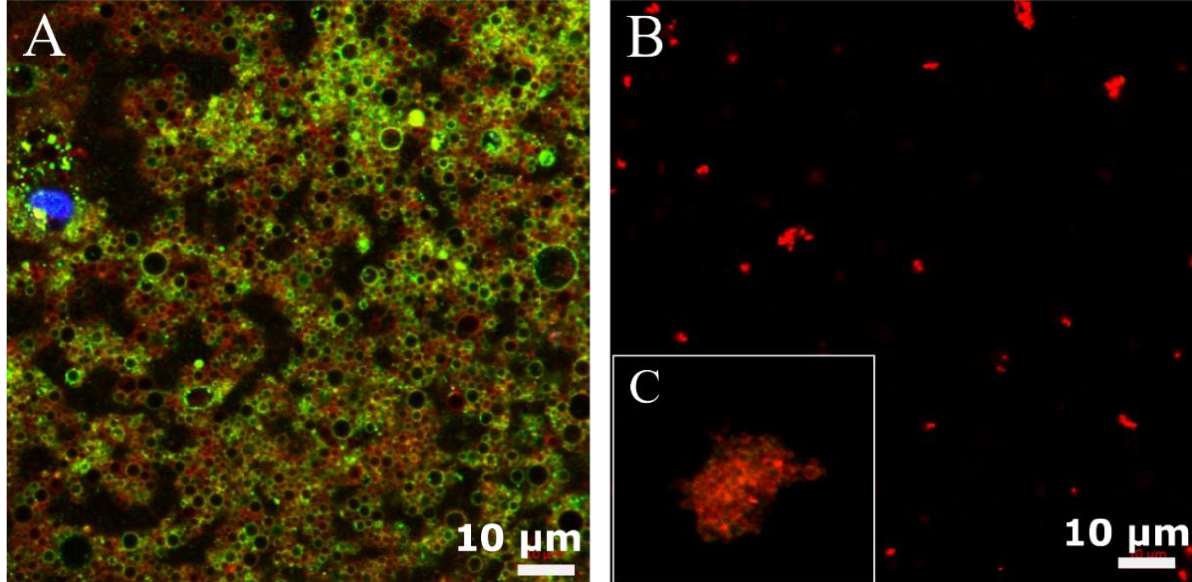
Figure 1. Confocal images of purified cell membrane; ( A ) cell membrane glycoproteins stained in green and plasma cell membranes stained in red, ( B ) isolated plasma cell membranes stained in red. Inset ( C ) shows a zoom-in of a single extracted membrane in figure ( B ).